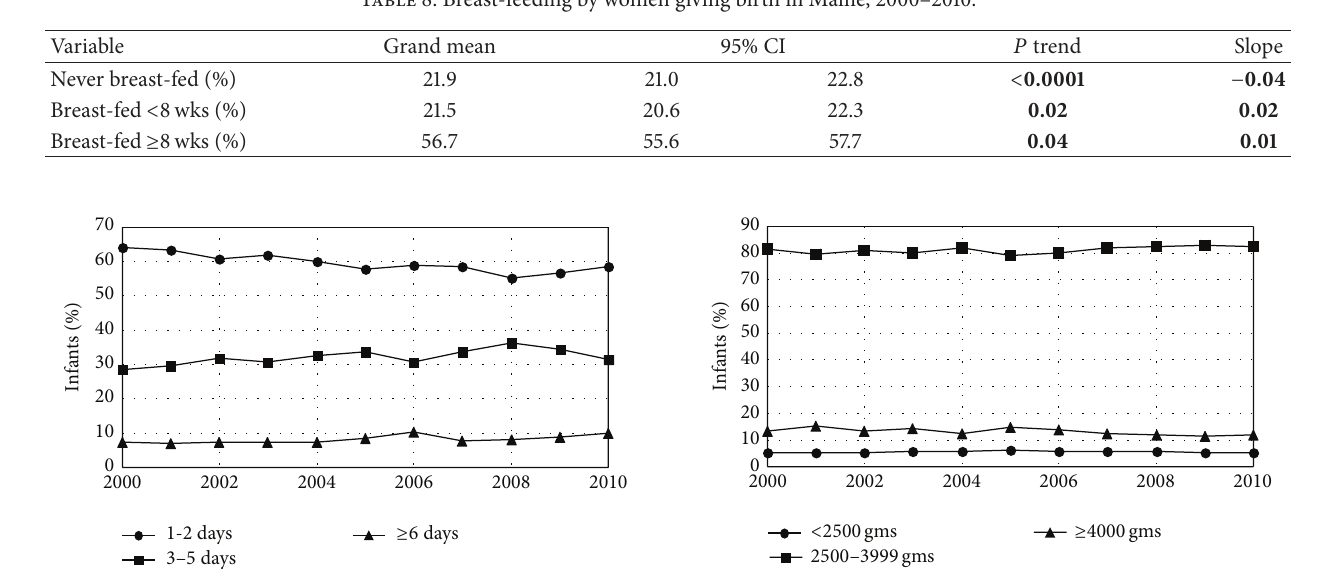
Table 8: Breast-feeding by women giving birth in Maine, 2000–2010.